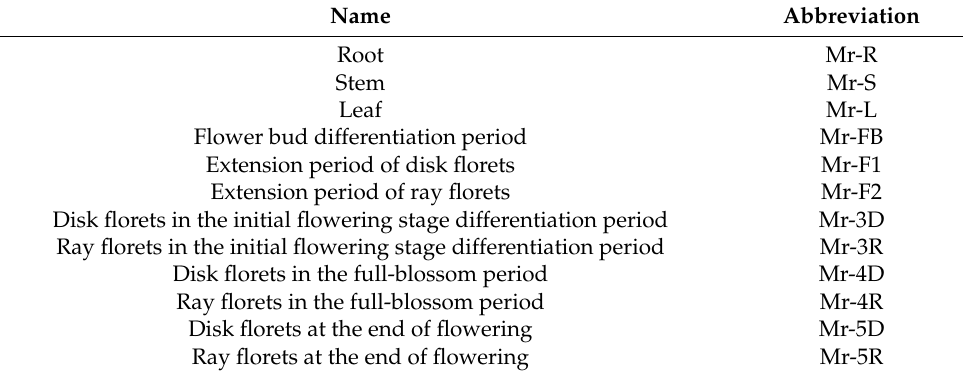
Table 3. Tissues and different flower developmental stages of German chamomile used in the present